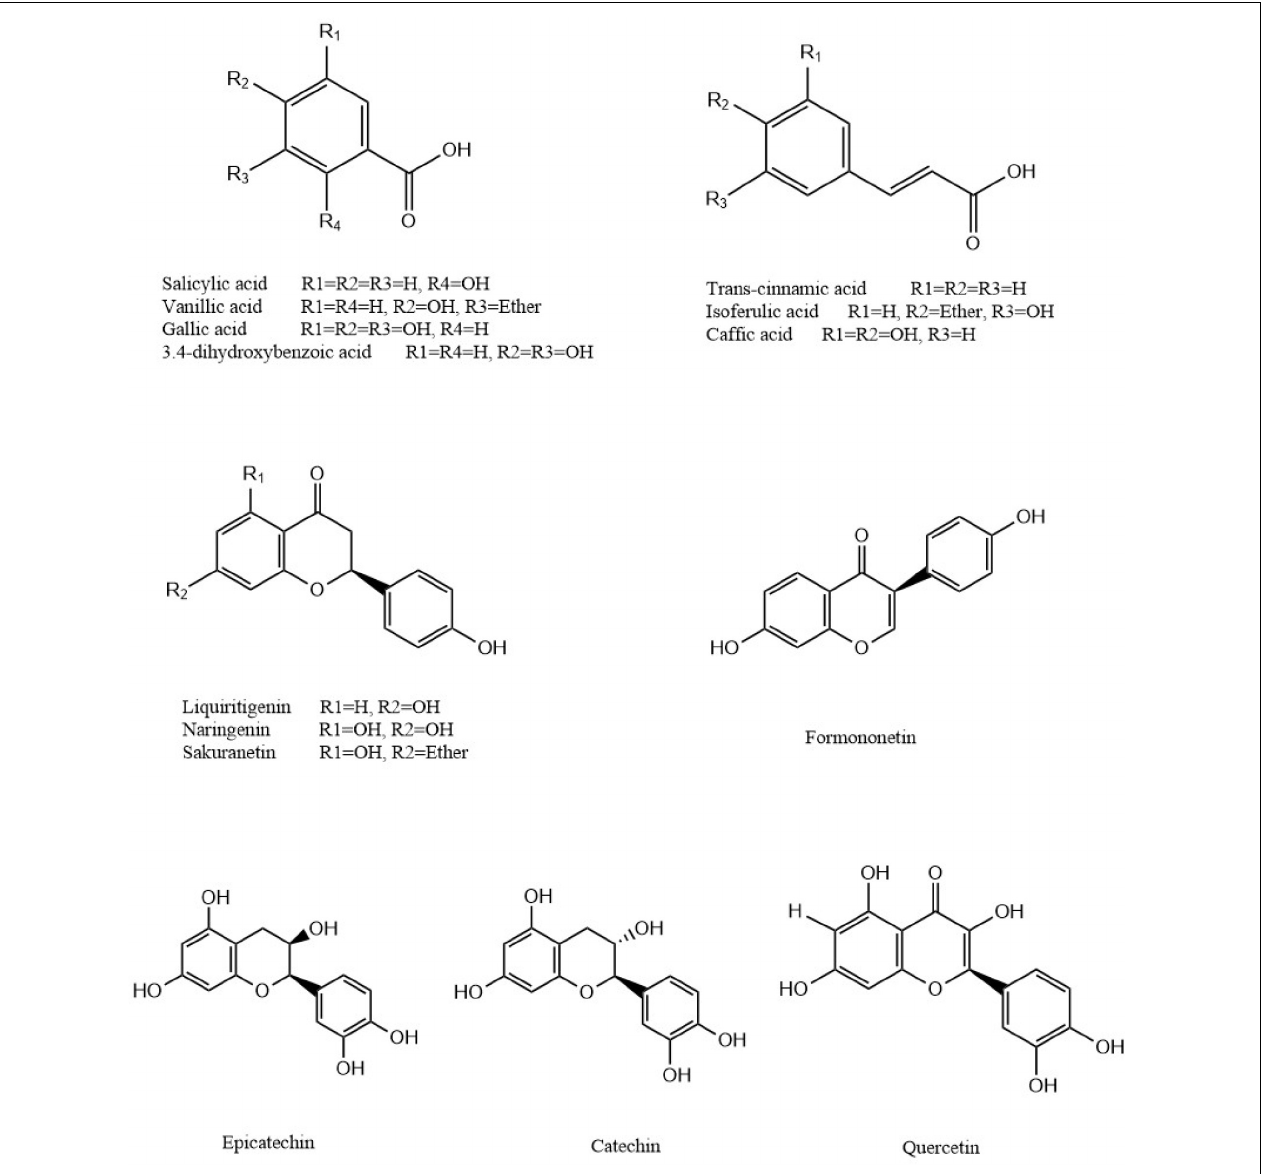
FIGURE 2 | Chemical structures of polyphenols identified in P. vicina